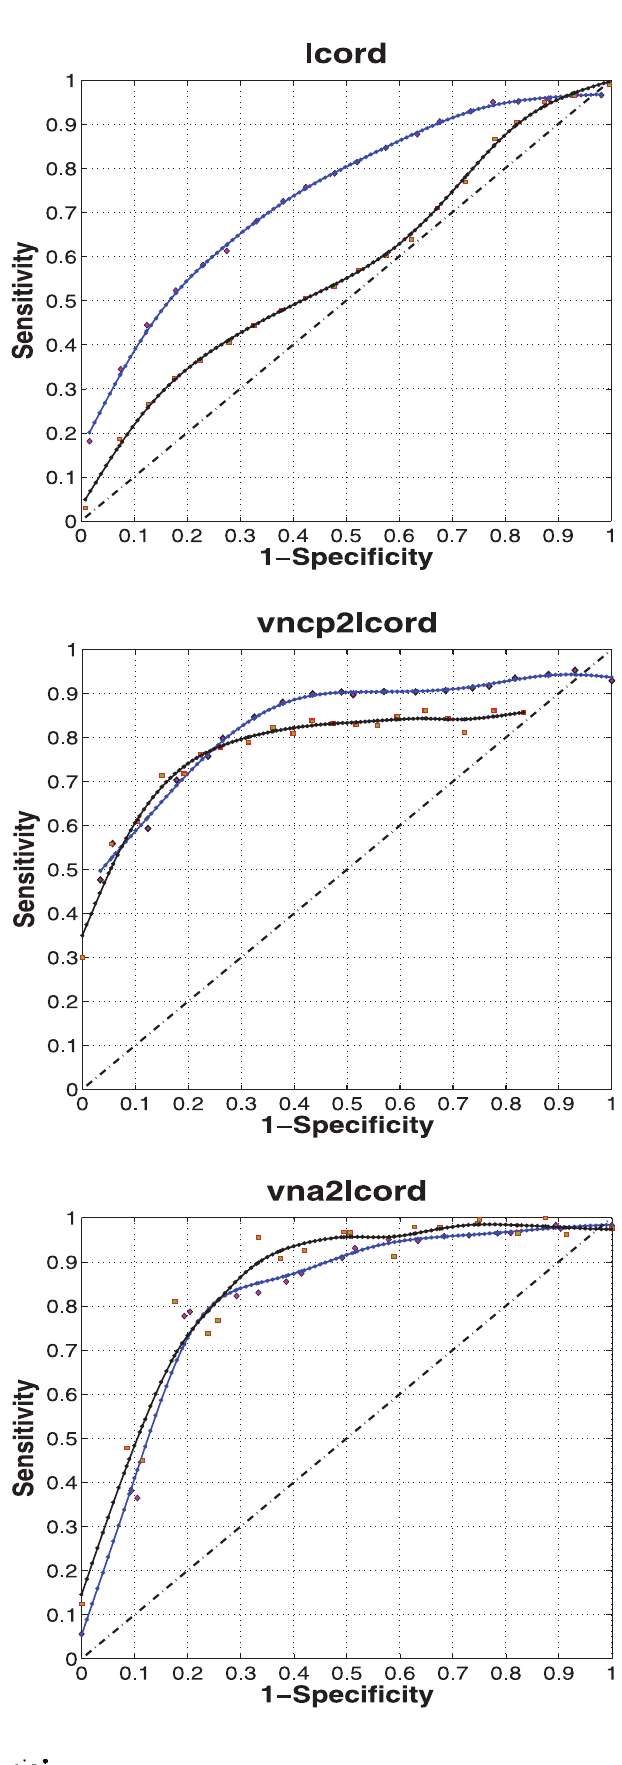
Figure 2. Estimation of Prediction Accuracy for Three Functional Units Constructed with Genes Involved in the Development of Embryonic CNS Discrimination (between the genes in the functional unit and genes that do not belong there) is shown by average ROC curves of SVM classifiers. The black and blue curves (radial basis function [RBF] and second-order polynomial kernels, respectively) are average ROC curves obtained with cubic smoothing spline, which approximate average sensitivity values. The average sensitivity values are green squares (RBF kernel) and magenta diamonds (second-order polynomial kernel). The diagonal line represents a classifier that makes random predictions. The classifier designed with the RBF kernel outperforms the classifier built with the second-order polynomial kernel, reaching peak performance character- istics of 80% sensitivity (true-positive rate) and specificity (1 (cid:2) false- positive rate). See Tables S2 and S3 and Figure S6 for